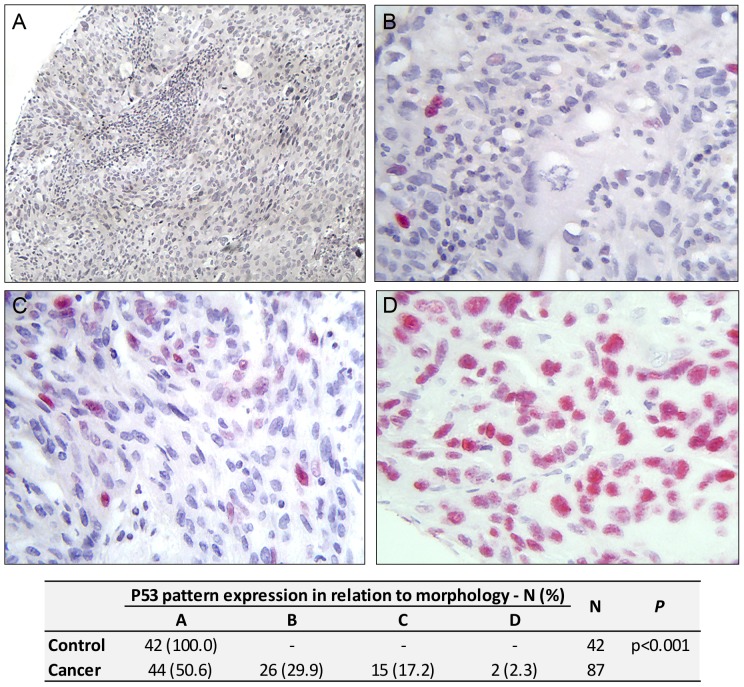
P53 expression.A, B, C and D: invasive cervical cancer epithelium. (A) negative; (B) less than 5% nuclear stain positivity; (C) 5% to 25% nuclear stain positivity; (D) higher than 25% (FastRed, red stain; Mag 40×, Fig A Mag.20×).